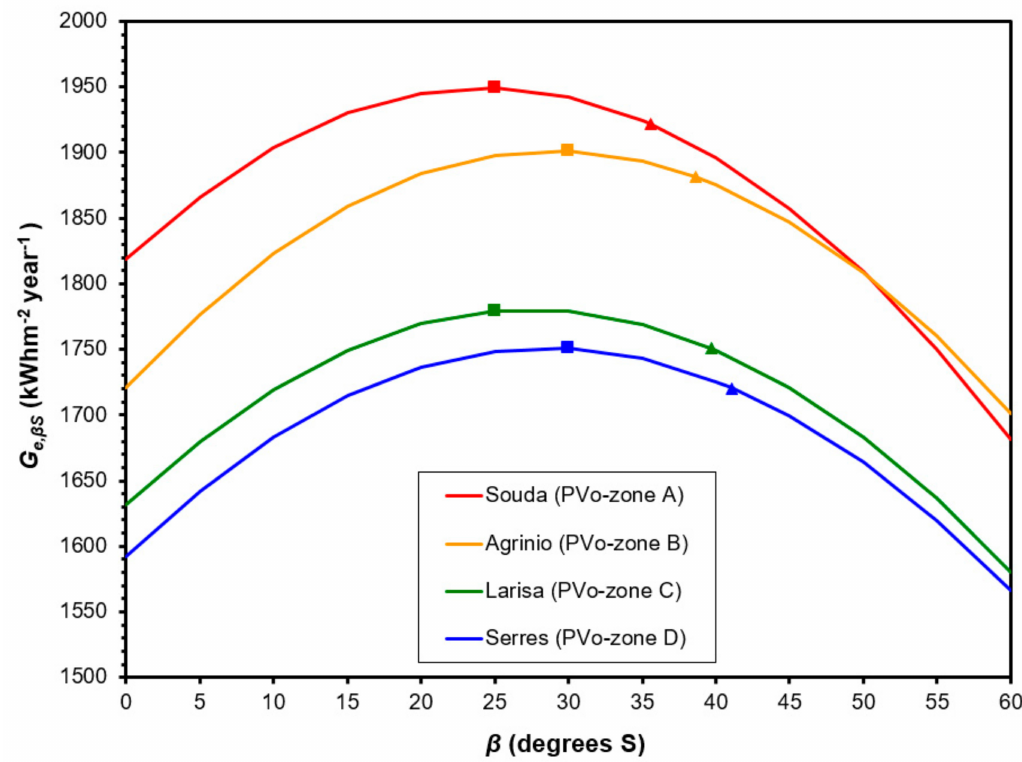
Figure 4. Solar energy yield per year G e, β S on the planes with tilt angles to the south in the range of 5–60 ◦ in steps of 5 ◦ at four representative sites in Greece. The maximum energy received per year in each site is presented by squares, and the energy received at tilt angles equal to ϕ ◦ is shown by triangles. The energy received by a horizontal flat plane ( β = 0 ◦ ) is also